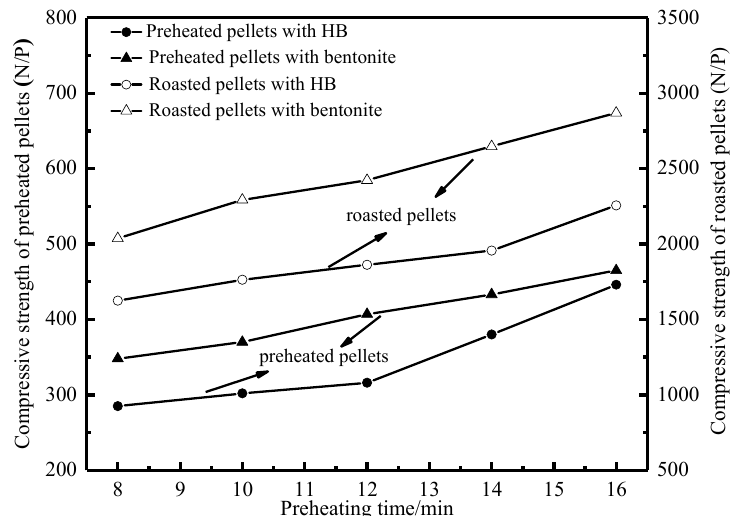
Figure 7. Effects of preheating time on the compressive strengths of pellets with binders, preheating temperature 920 °C for humic substance-based binder (HB) and bentonite.